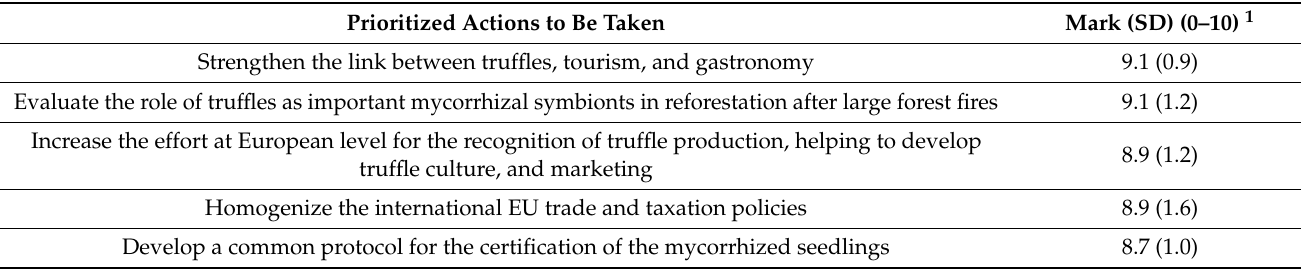
Table 4. Top prioritized actions to be taken in the truffle sector identified by the truffle expert panel at the end of the second round (only marks higher than 8.5 have been included in the